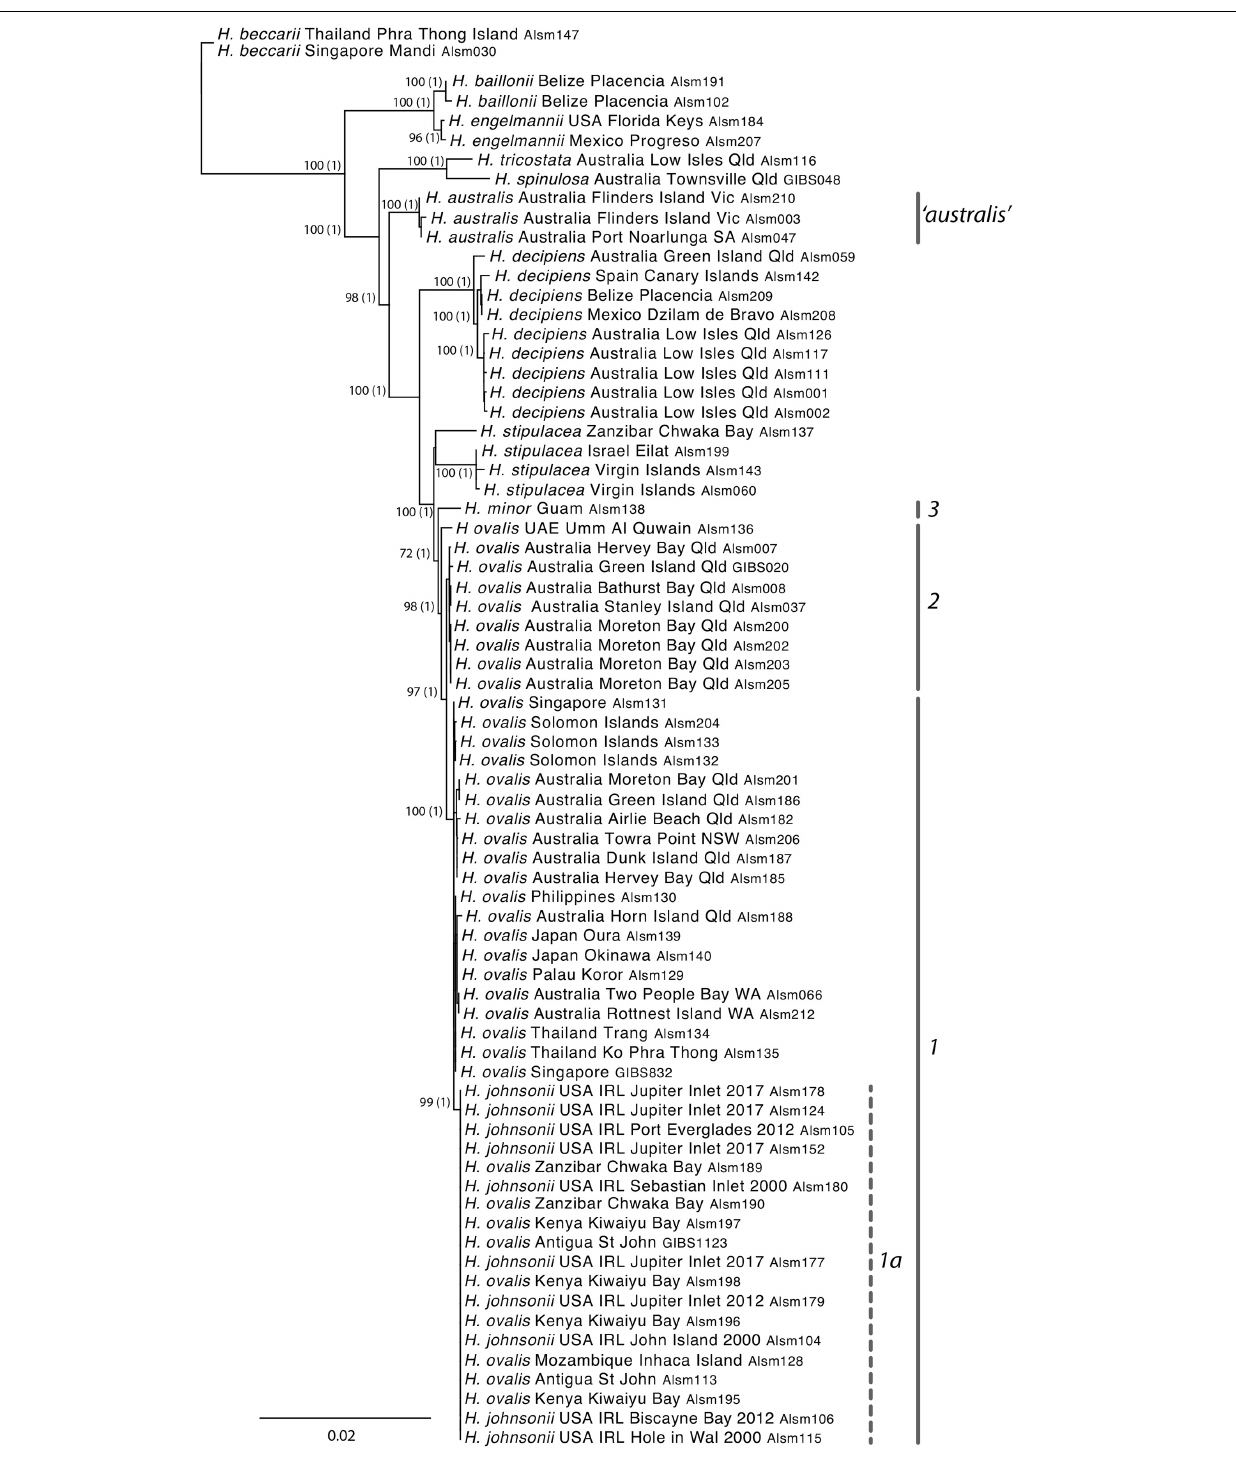
Frontiers in Marine Science |